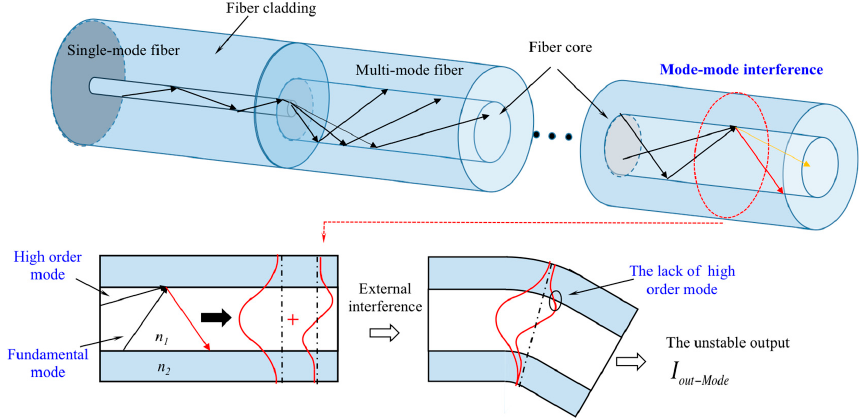
Figure 8. Schematic of single-mode (SM)–multi-mode (MM) fiber coupling in the optical system.